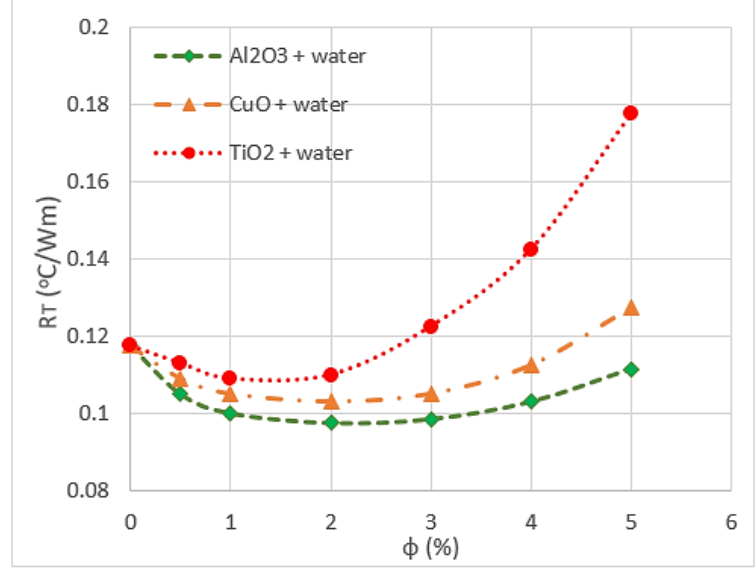
Figure 5. Variation of overall thermal resistance (R T ) with volume fraction ( φ ). [82]